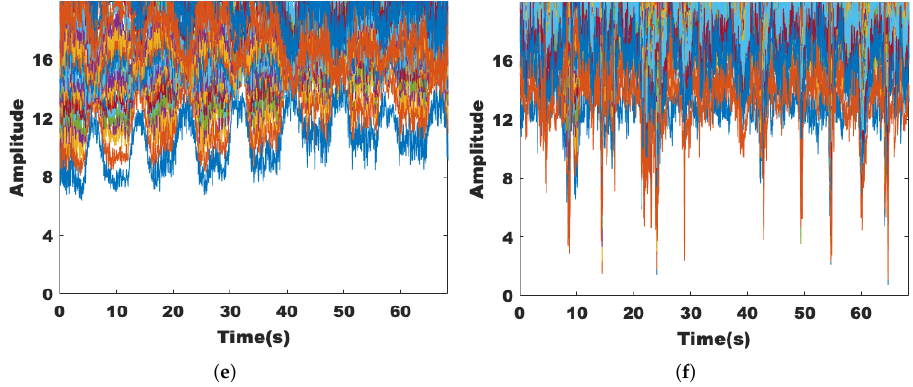
Figure 5. Performance of different data streams. ( a ) With target breathing, Rx = 1. ( b ) With target moving, Rx = 1. ( c ) With target breathing, Rx = 2. ( d ) With target moving, Rx = 2. ( e ) With target breathing, Rx = 3. ( f ) With target moving, Rx = 3.